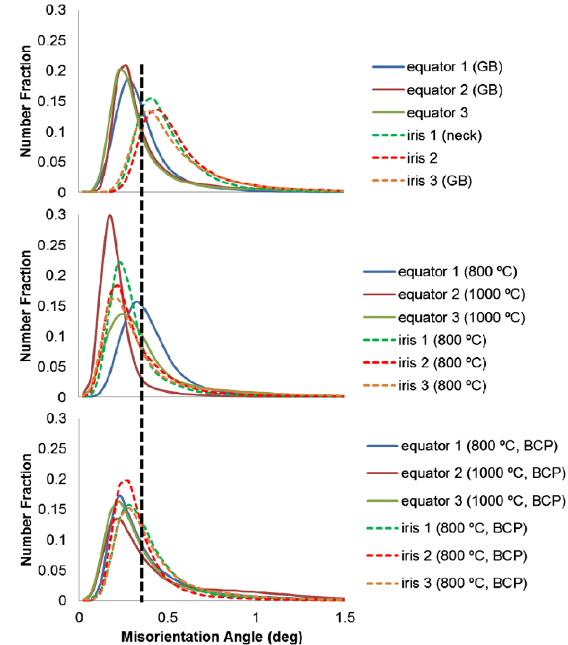
FIG. 8. LAM histograms of the six EBSD scans for as-deep drawn (top), after annealing (middle), and after BCP (bottom). Horizontal scale is